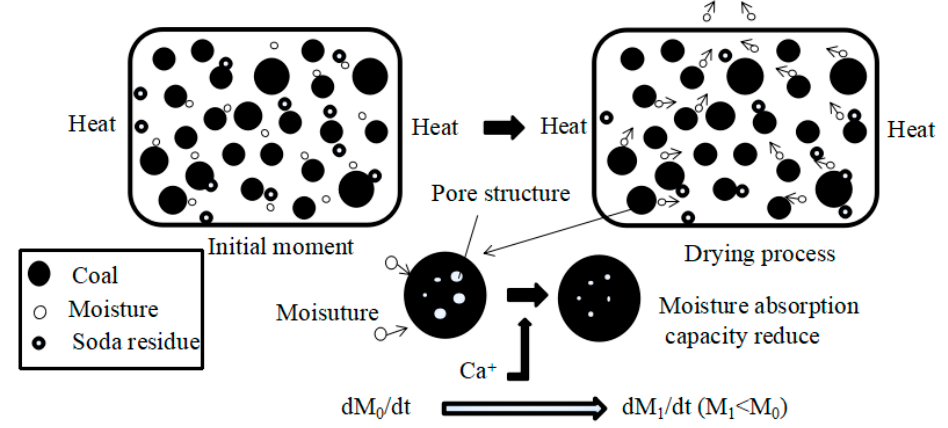
Figure 5. The influence mechanism of soda residue composition on coal moisture absorption and transfer.